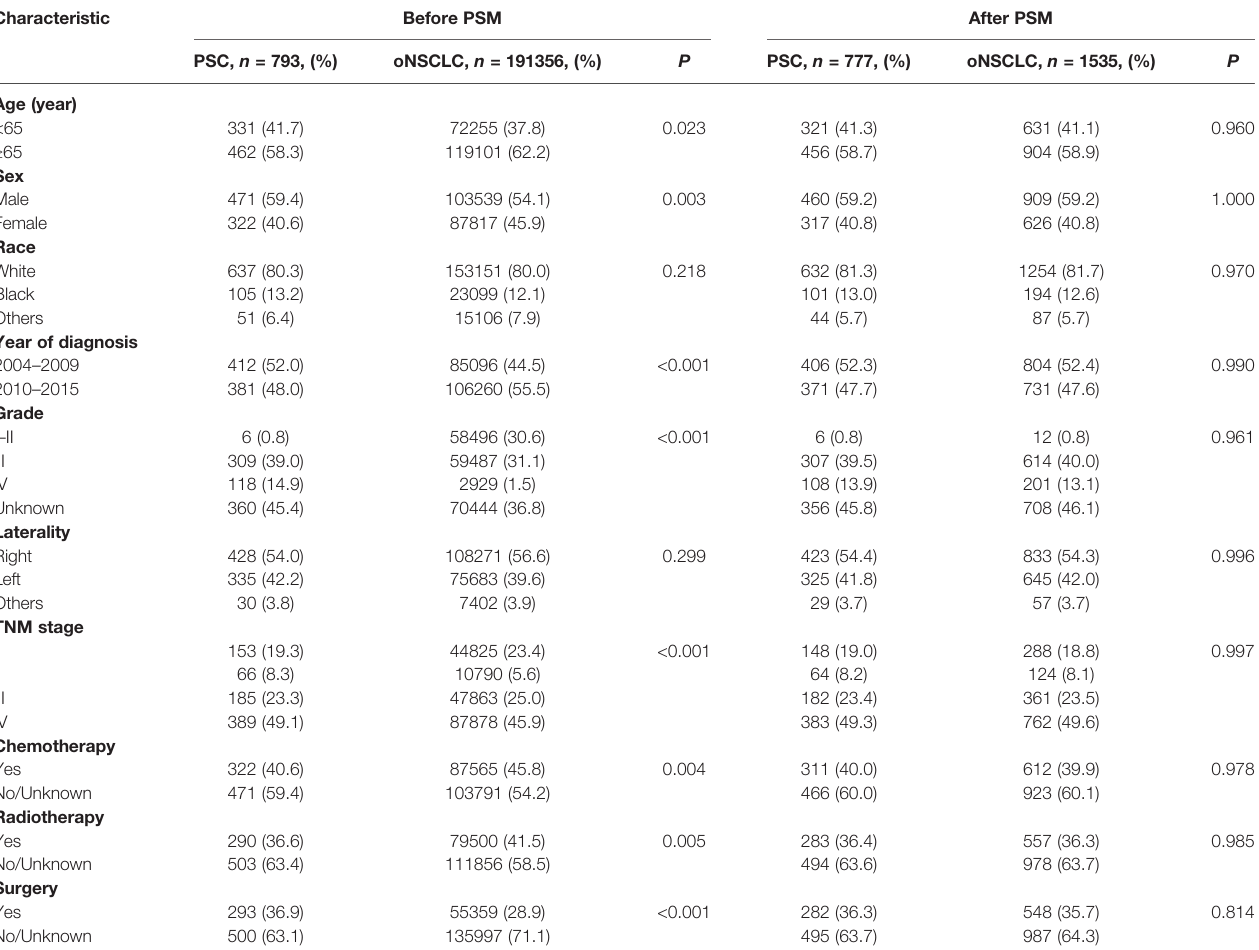
TABLE 1 | Comparison of clinicopathological characteristics between PSC and oNSCLC. Characteristic Before